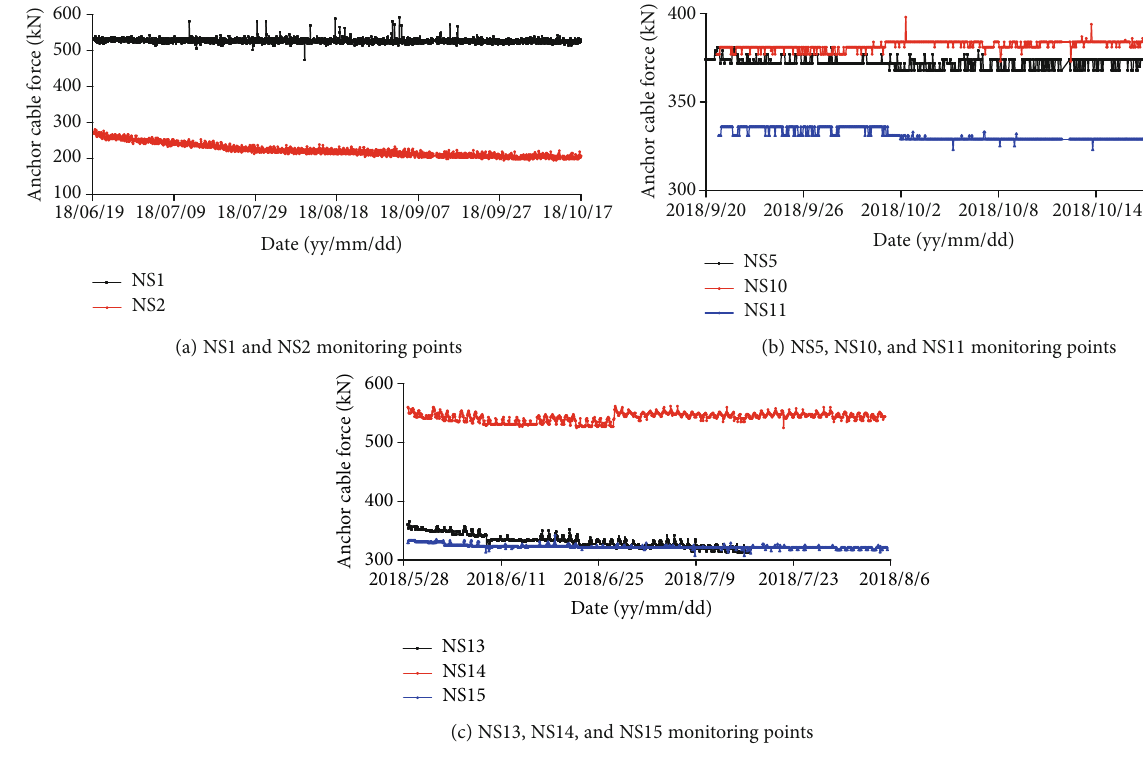
Figure 15: Curves of anchor cable